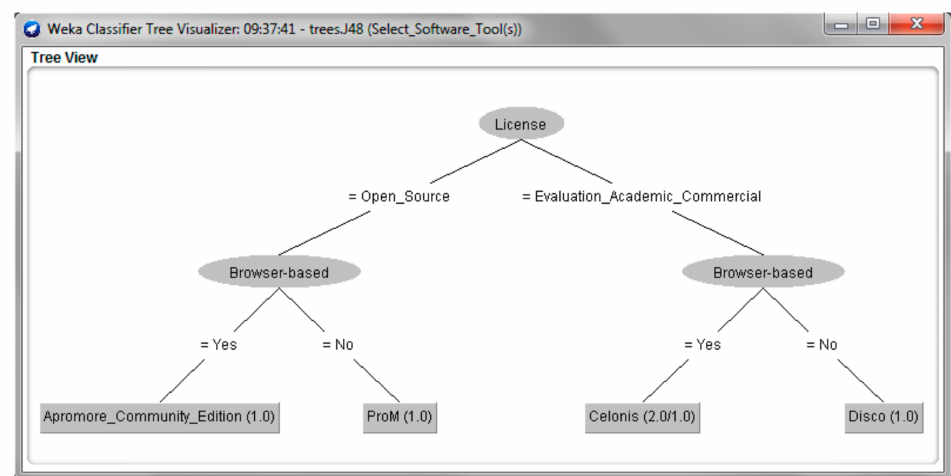
Figure 7. Generated decision tree (Weka 3.8.4).